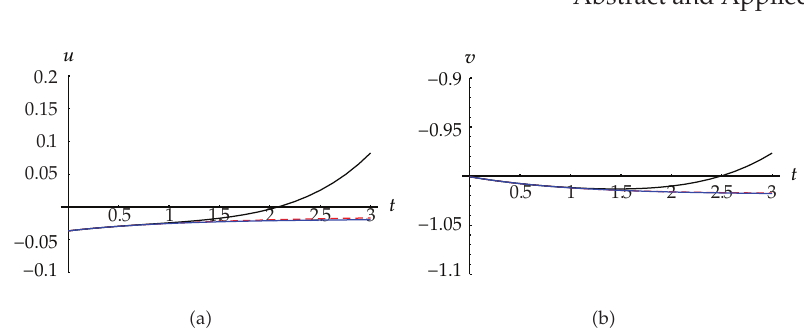
Figure 3: The compared results for the GDTM solutions (cid:4) black (cid:5) , the GDTM-Pad´e solutions (cid:4) red (cid:5) , and the exact solutions (cid:4) blue (cid:5) of (cid:4) 1.2 (cid:5) when c (cid:8) − 0 . 5, d (cid:8) − 2 and n (cid:8) 1.